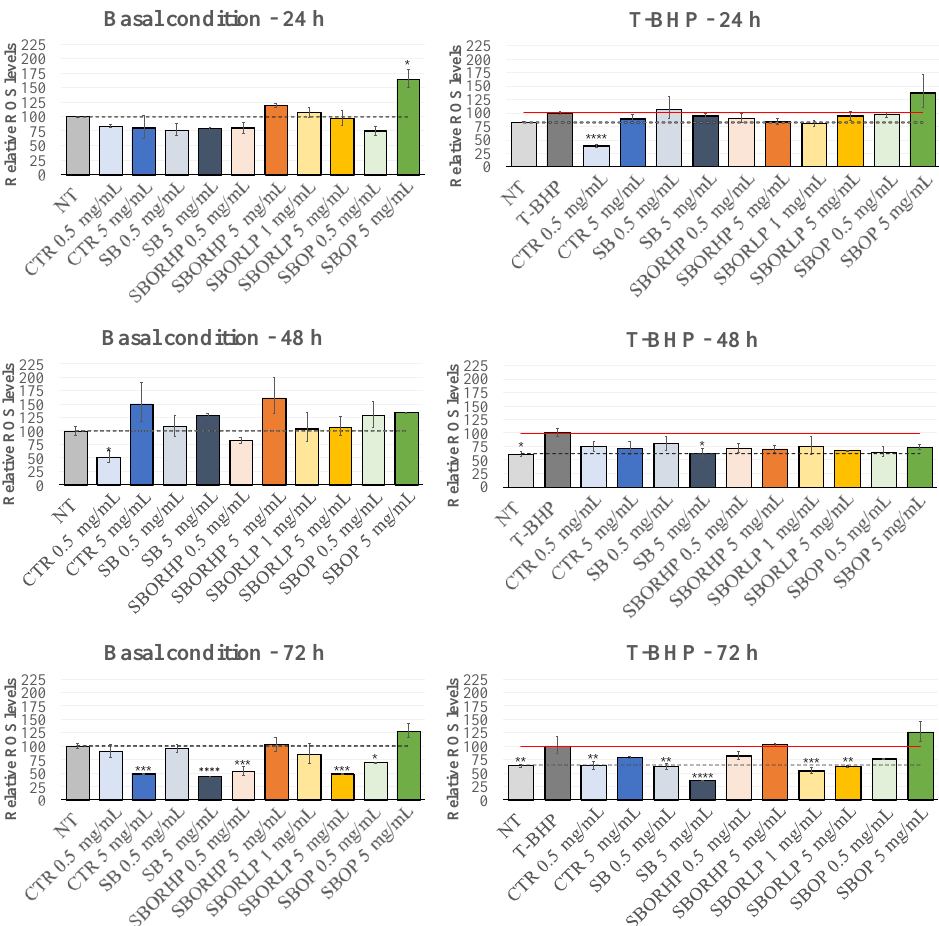
Figure 6. ROS detection performed on the H9c2 cell line. Cells were treated for 24 h, 48 h and 72 h with different samples of red onions at two different concentrations, and the ROS levels were measured by the DCF assay under the basal conditions and after exposure to the exogenous inducer of oxidative stress, T-BHP. Data were the, means ± SEM from at least 3 independent experiments under each condition and were expressed as the percentage of vehicle-treated cells (dotted line) or tert-Butyl hydroperoxide-treated-cells (T-BHP) (red line). Statistical analyses were performed using Brown–Forsythe and Welch one-way analysis of variance, and mean comparisons were made using the unpaired t - test with Welch’s correction. * p < 0.05, ** p < 0.01, *** p < 0.001, **** p < 0.0001.